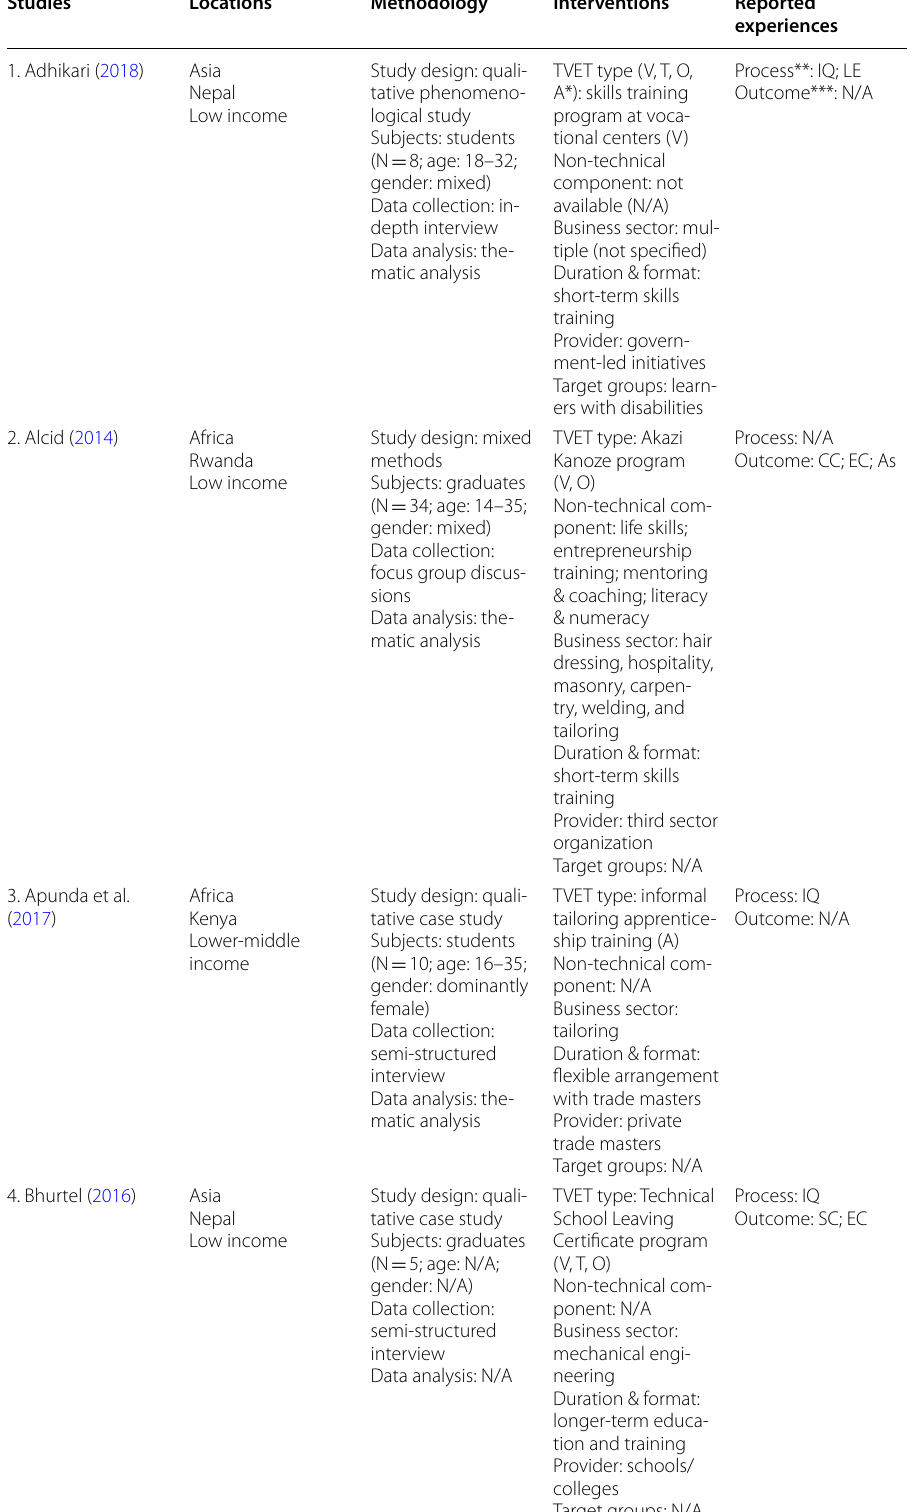
Table 2 A description of the included studies Studies